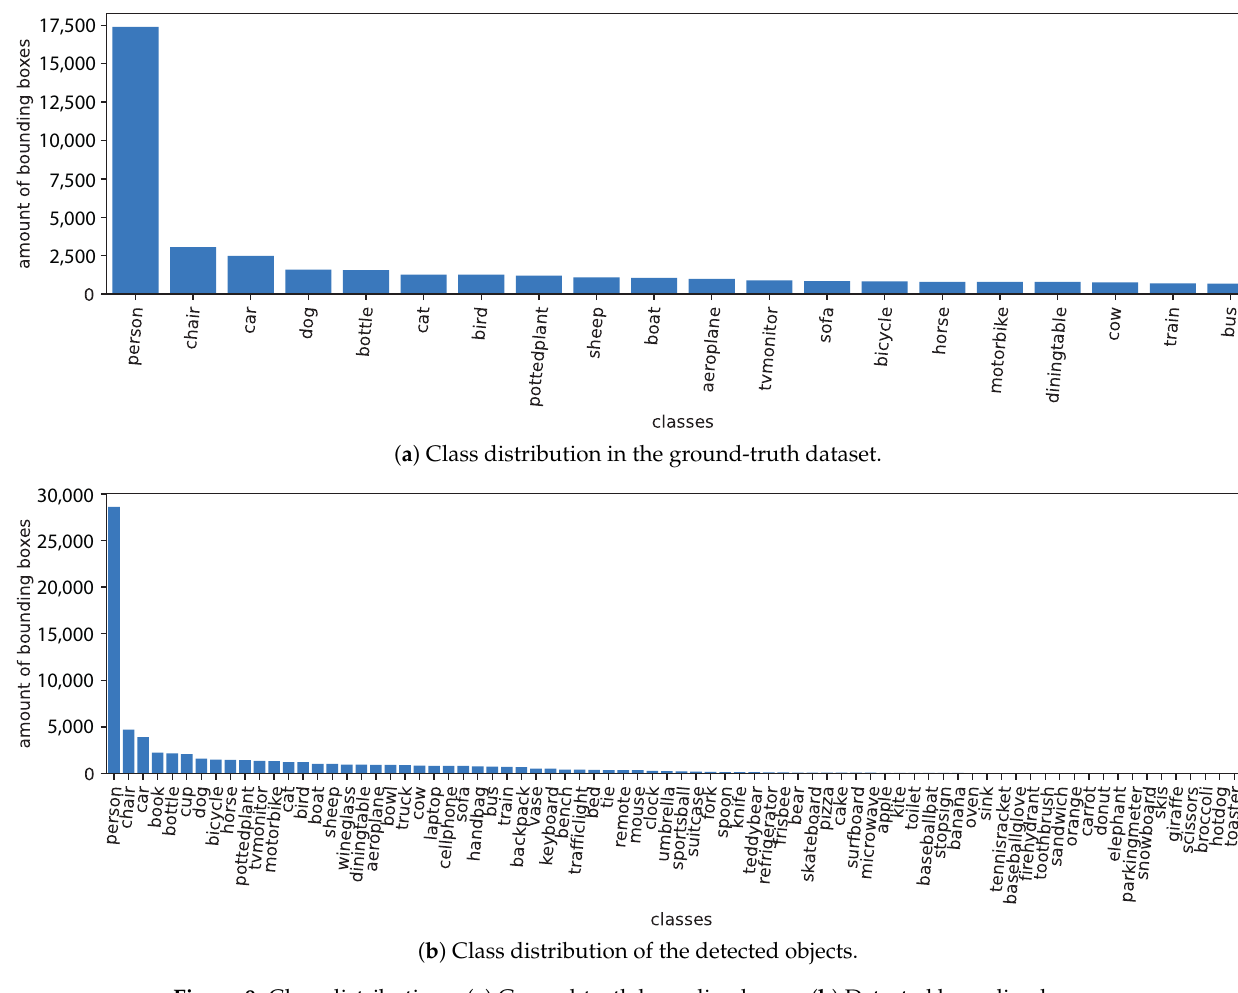
Figure 9. Class distributions: ( a ) Ground-truth bounding boxes. ( b ) Detected bounding boxes. The AP results for each class are presented in Table 5. The highest AP values over all classes were obtained when the AUC was measured with the 11-point interpolation method and an IOU threshold of t = 0.5, resulting in mAP = 0.58. As expected for all cases, a more rigorous IOU threshold ( t = 0.75) resulted in a smaller AP. Comparing the individual AP results among all classes, the most difficult object for all interpolation methods was the potted plant , having an AP not higher than 0.37 for an IOU threshold of t = 0.5 and an AP not higher than 0.22 with an IOU threshold of t =